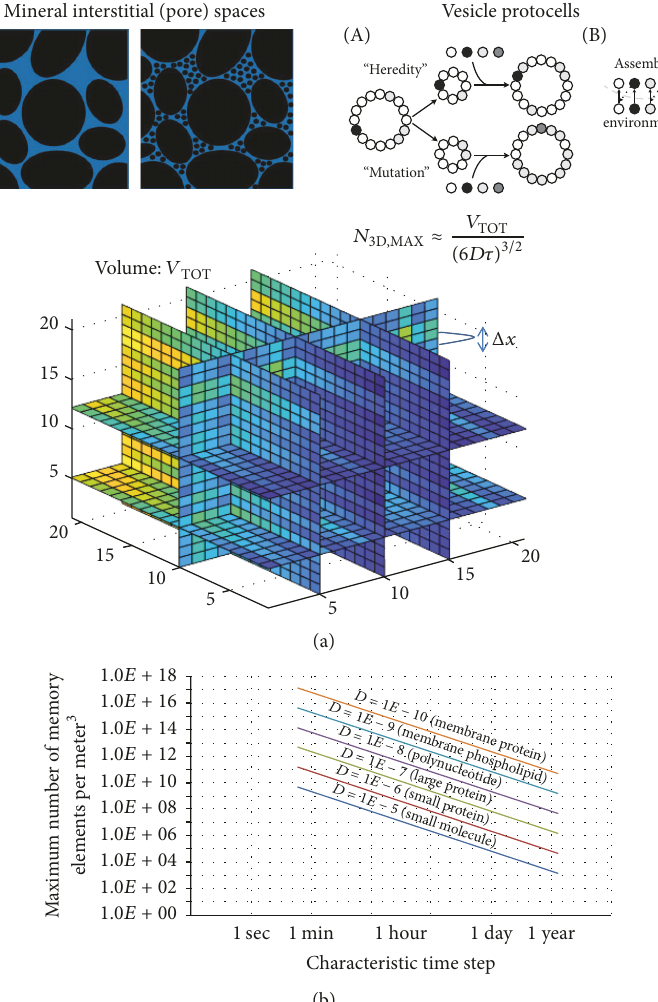
Figure 8: (a) Simplified dimensionless depiction of a sample volume subdivided by mineral grains or vesicle protocells (top) into a 3D array of adjacent memory elements with differing local concentrations of a compound of interest (shaded blocks, bottom). (b) Maximum number of 3D diffusion-limited memory elements per cubic meter. The width of the lines in plot (b) corresponds to variation caused by temperatures ranging from 20 ∘ C to 250 ∘